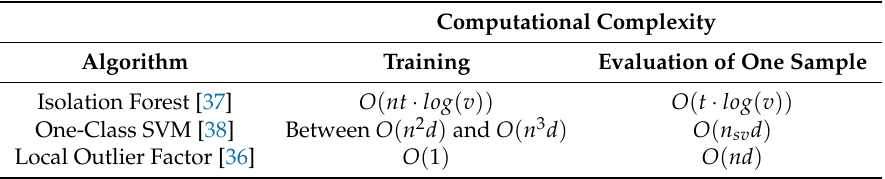
Table 2. Computational complexity of IF, OC-SVM, and LOF. The variables are explained in the text.